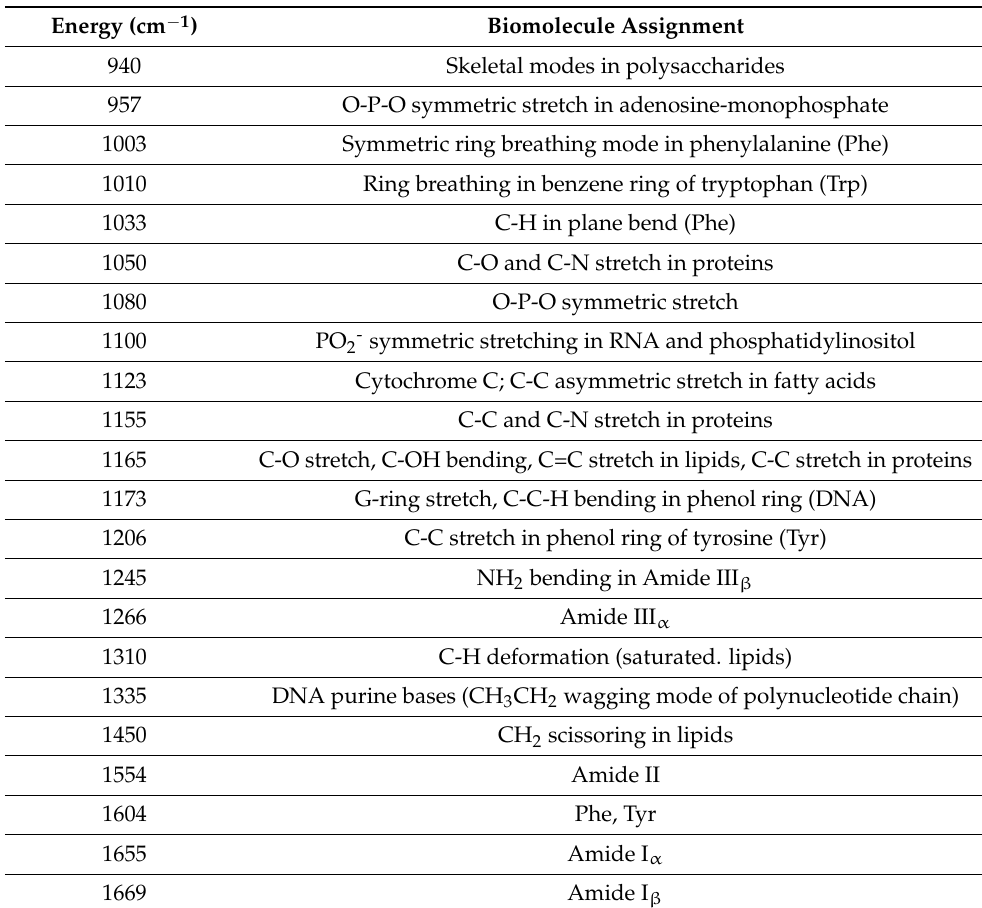
Table 1. Vibrations in BM-MSCs and their energies noticed in obtained Raman spectra. Adapted from